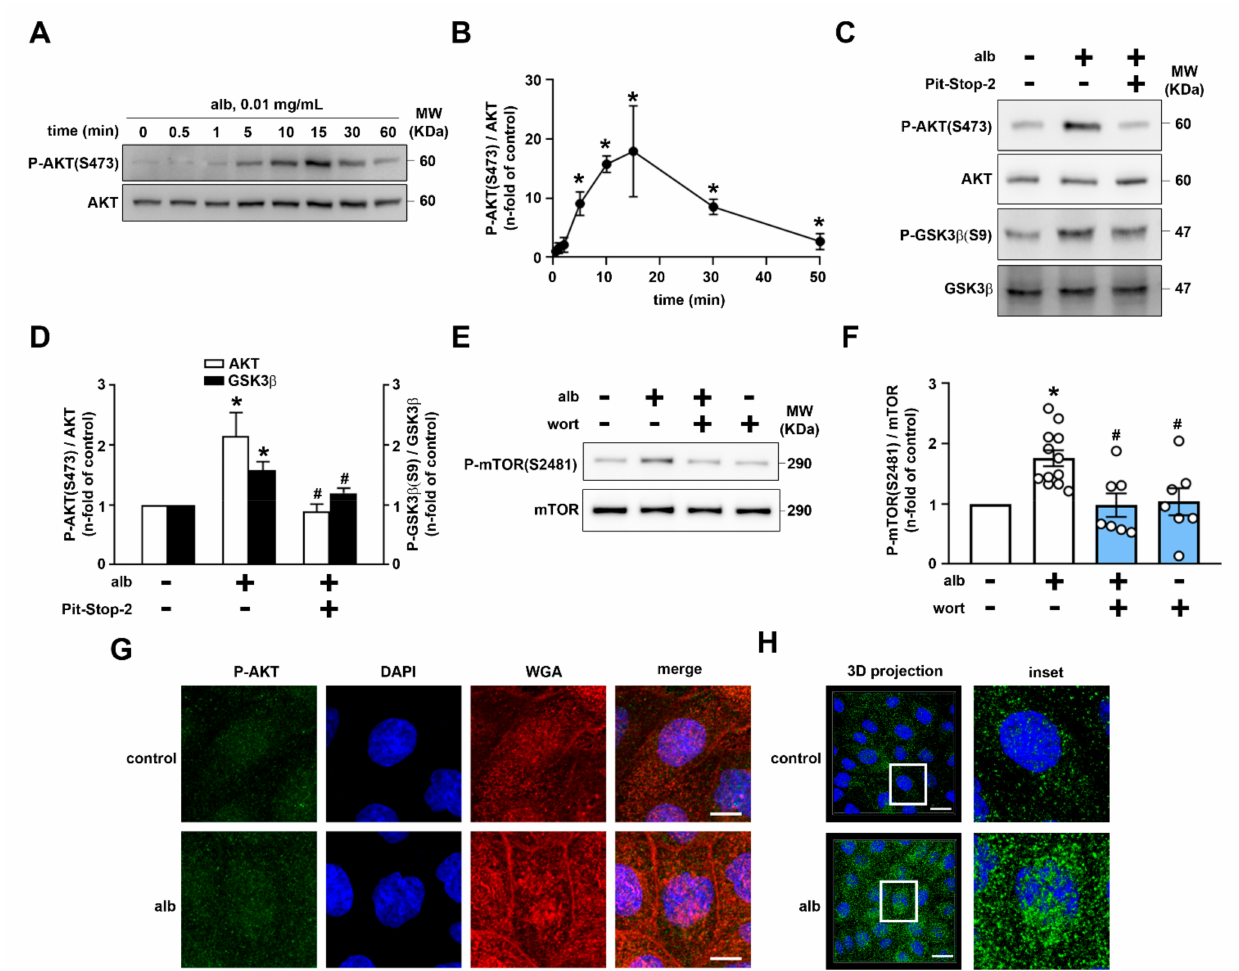
Figure 4. Albumin endocytosis promotes PI3K/AKT pathway activation in LLC-PK1 cells. ( A , C ) Representative immunoblotting showing both phosphorylated AKT at serine 473 (P-AKT S473) and total AKT in the cells treated with 0.01 mg/mL albumin. ( A ) Time course of the albumin (Alb) effect and ( B ) densitometric analysis represented as fold of control (n = 3). ( C ) Representative immunoblotting showing P-AKT S473, total AKT, phosphorylated GSK3 β at serine 9 (P-GSK3 β S9), and total GSK3 β of cells treated with 0.01 mg/mL albumin for 15 min in the absence or in the presence of previous pre-treatment with 15 µ M Pit-Stop-2 for 15 min (n = 4). ( D ) Densitometric analysis is represented as fold of control. ( E ) Representative immunoblotting showing phosphorylated mTOR complex 2 at serine 2481 (P-mTOR S2481) and total mTOR in the cells treated with 0.01 mg/mL albumin for 15 min in the absence or presence of previous pre-treatment with wortmannin (WORT) for 15 min (n = 7). ( F ) Densitometric analysis is represented as fold of control. ( G ) Representative confocal images of immunofluorescence for P-AKT S473 (green), cell membrane marker (WGA lectin, red), and nuclei (DAPI, blue, n = 3). Scale bar = 10 µ m. ( H ) Representative image of 3D projection of a P-AKT S473 positive signal and DAPI are shown. White rectangle represents the inset area. Scale bar = 10 µ m. All data are presented as means ± standard deviation. * p < 0.05 versus control, # p < 0.05 versus albumin One-way ANOVA with Dunn’s multiple comparisons (AKT, C ) or Tukey’s multiple comparisons (GSK3 β , C , E ) was